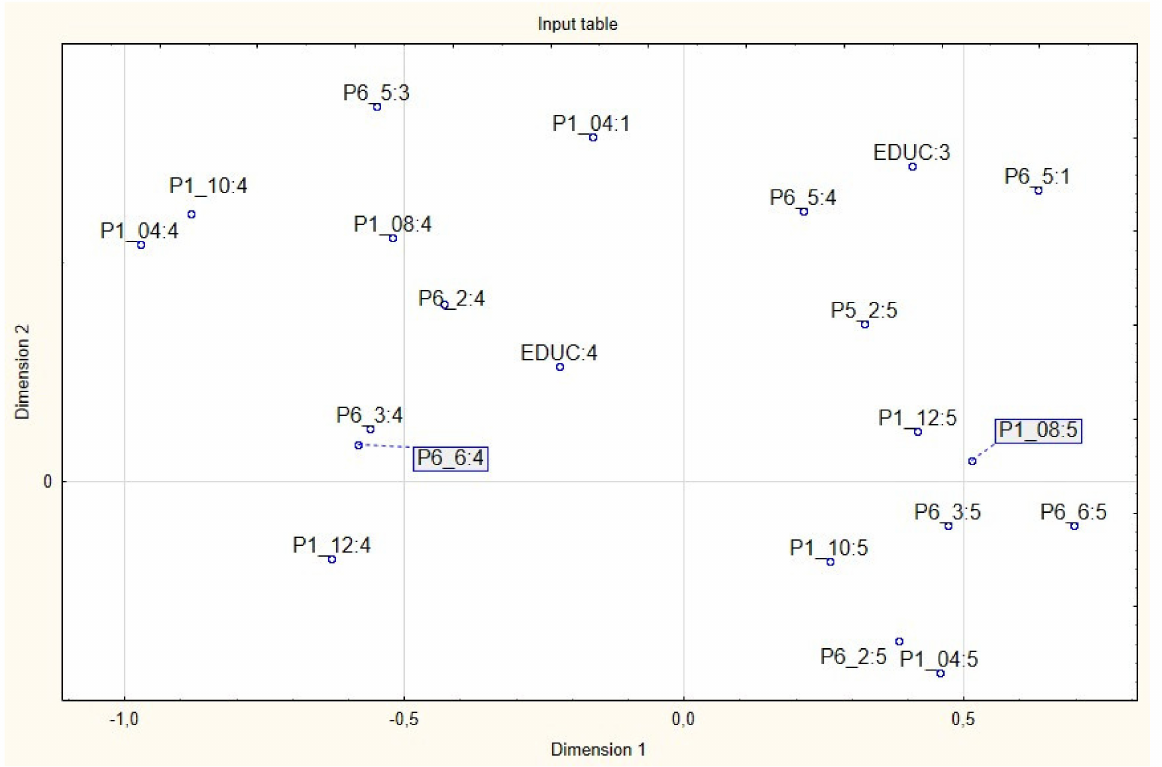
Figure 3. Two-dimensional perception map for the variables education and subjective evaluation of salary in energy